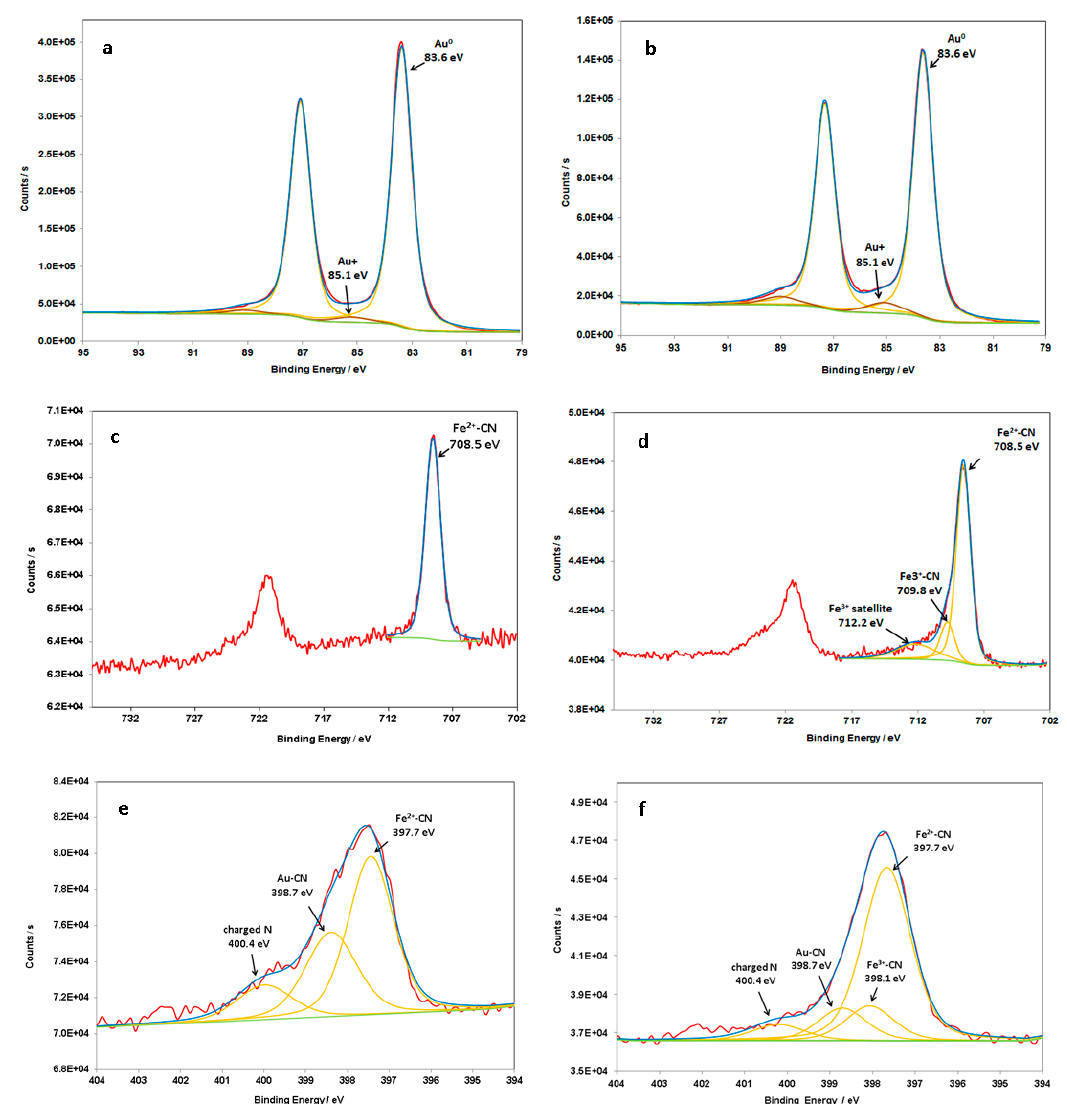
Figure 12. XPS spectra of the Au4f ( a , b ), Fe2p ( c , d ), and N1s ( e , f ) core levels of 30 nm-Au-NPs@citrate after reaction under LEDs irradiation at 520 nm (during 60 min) for deaerated solutions containing hexacyanoferrate ( a , c , e ) with or ( b , d , f ) without sodium thiosulfate.